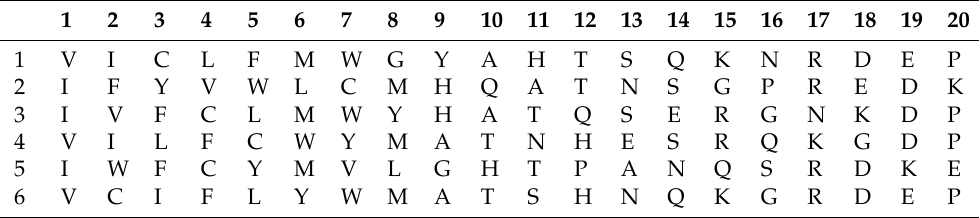
Table 2. The amyloidogenecity order of the amino acids, decreasing from left to